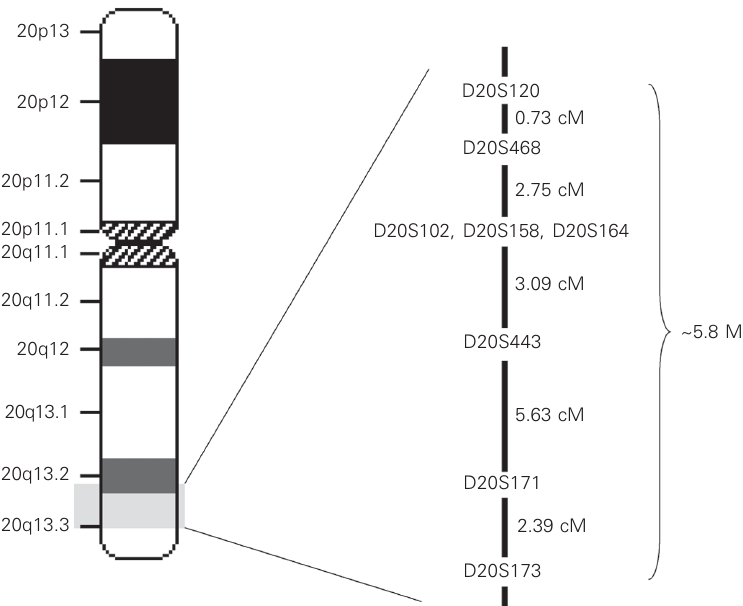
Figure 2. Genetic map of the SMAN1 locus on chromosome 20q13.2-13.3. Location of genetic markers (cM) were obtained from MapView (http://www.ncbi.nlm.nih.gov/